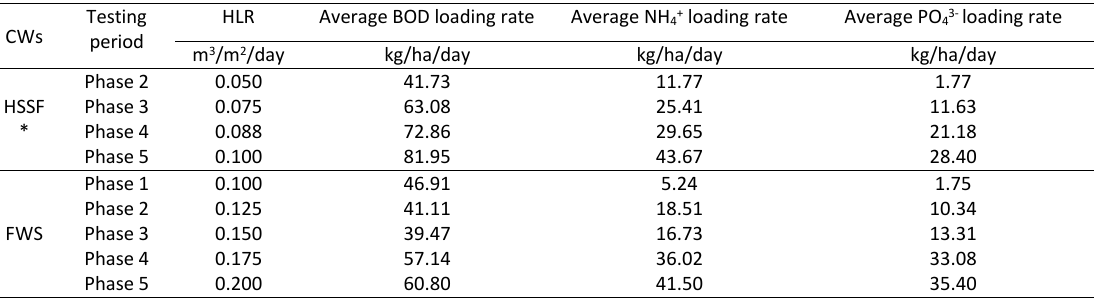
Table 2: Tesng HLRs and input pollutant loading rates